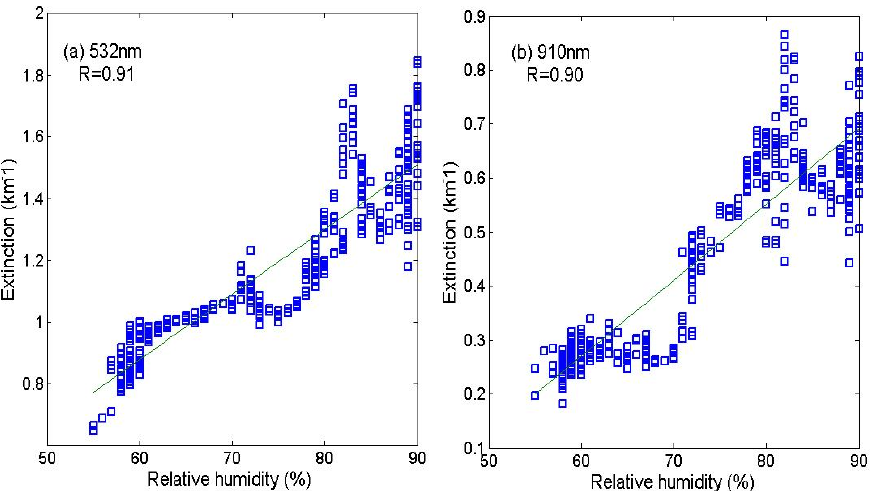
Figure 4. Comparison between relative humidity and extinction coefficient for ( a ) 532 nm and ( b ) 910 nm. ( b ) 910